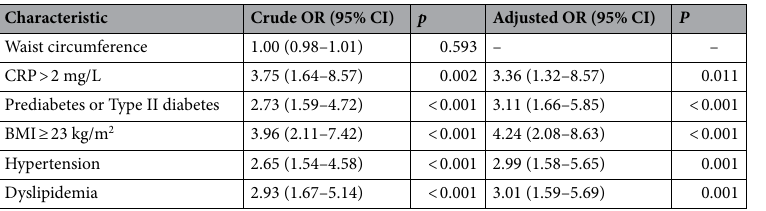
Table 6. Associations between metabolic traits and MAFLD-HCC in patients without high FIB-4 on univariate and multivariate logistic regression analysis. FIB-4 fibrosis-4, BMI body mass index.